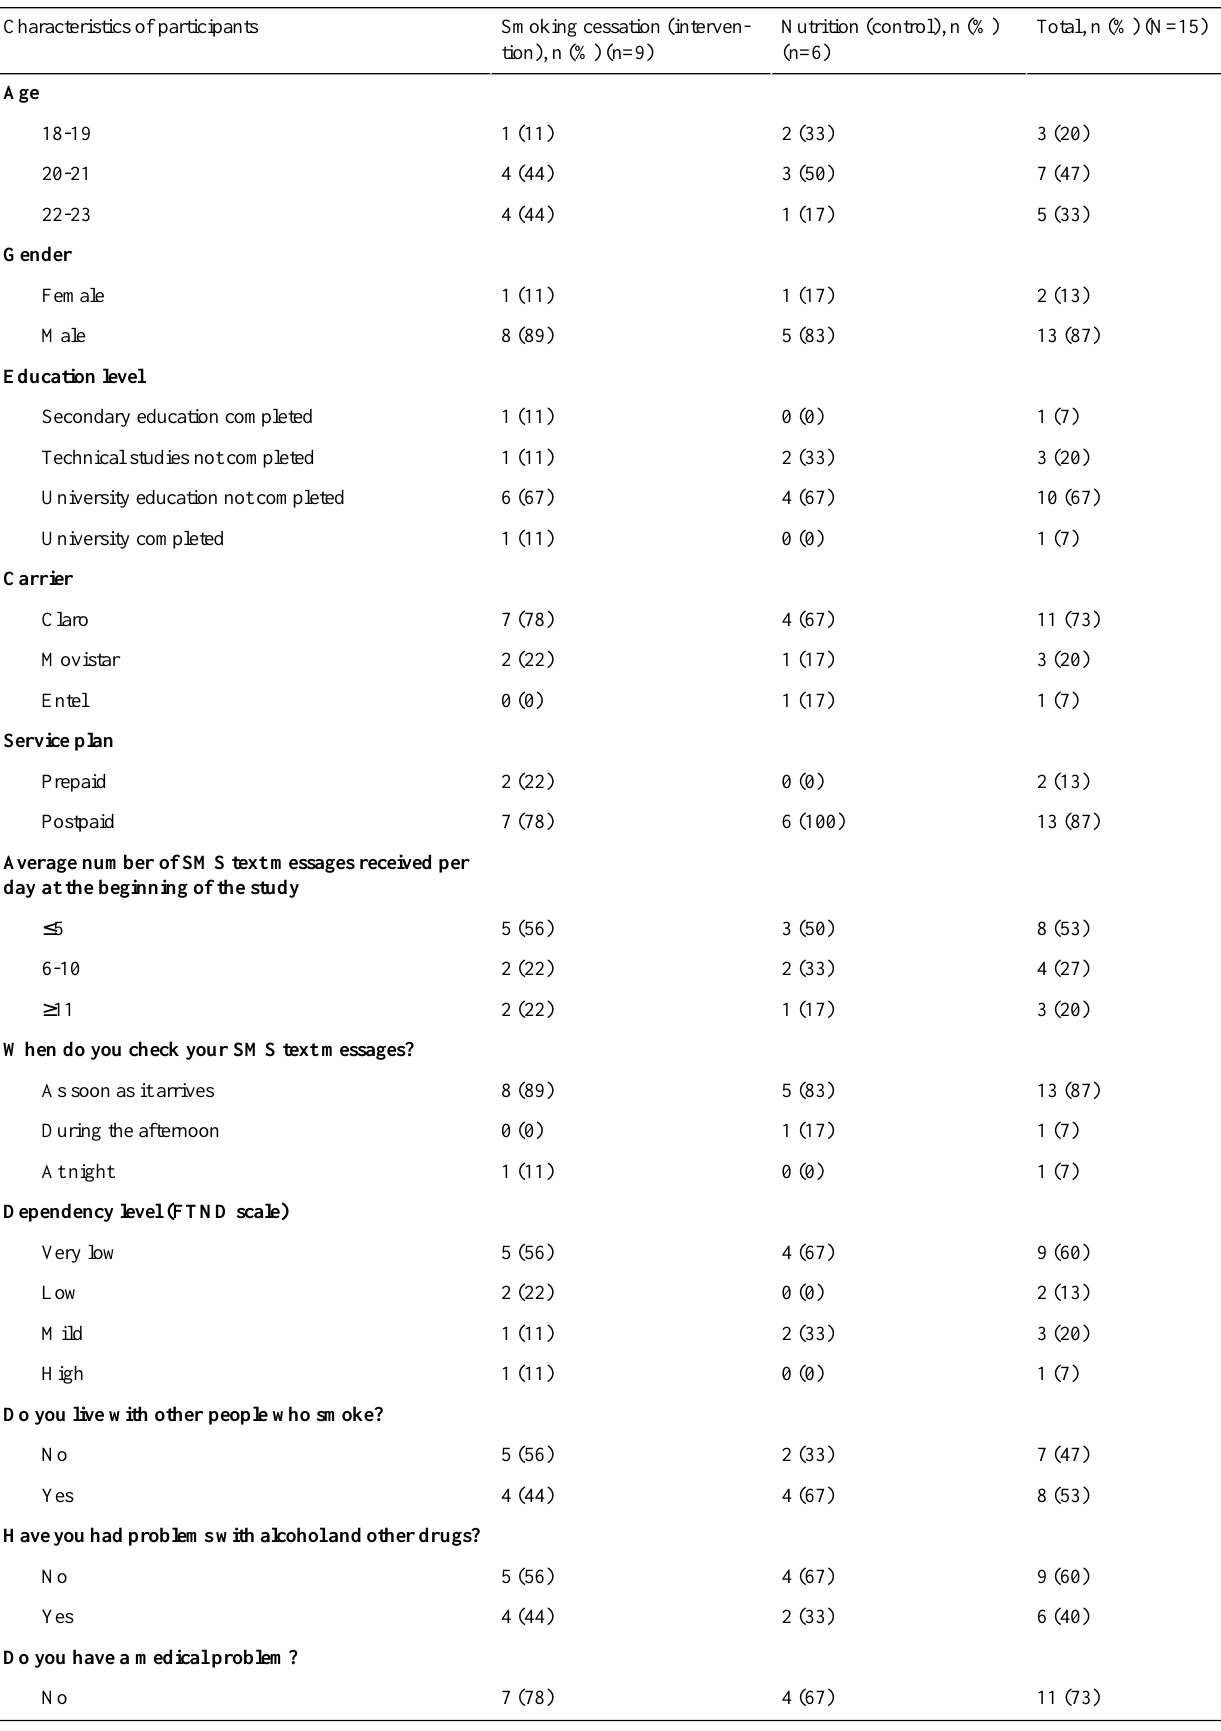
Table 1. Characteristics of participants in the SMS text message smoking cessation program